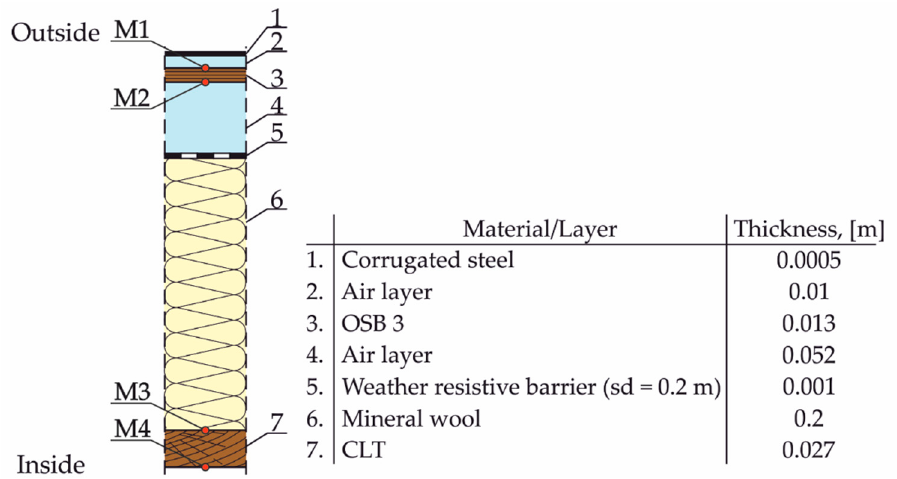
Figure 3. Basic parameters for the roof layers and positioning of monitors (M1, M2, M3, and M4).